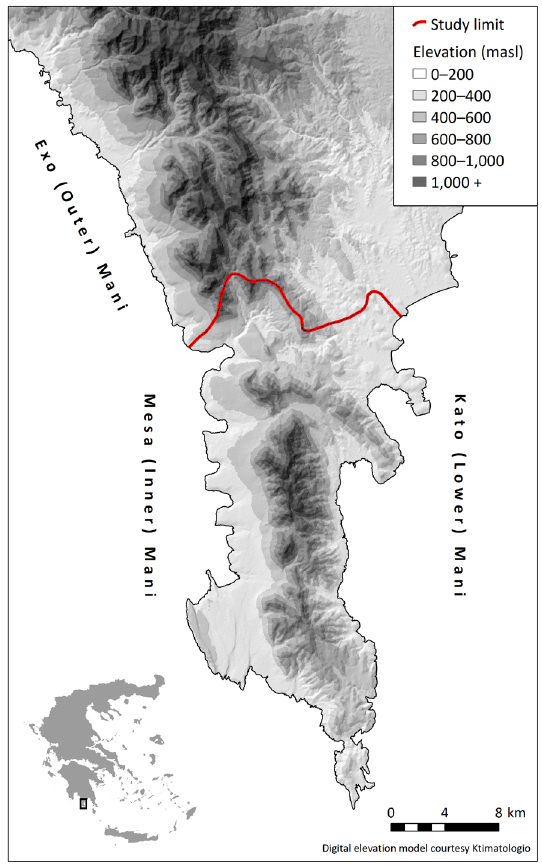
Figure 2. Map of the southern Mani